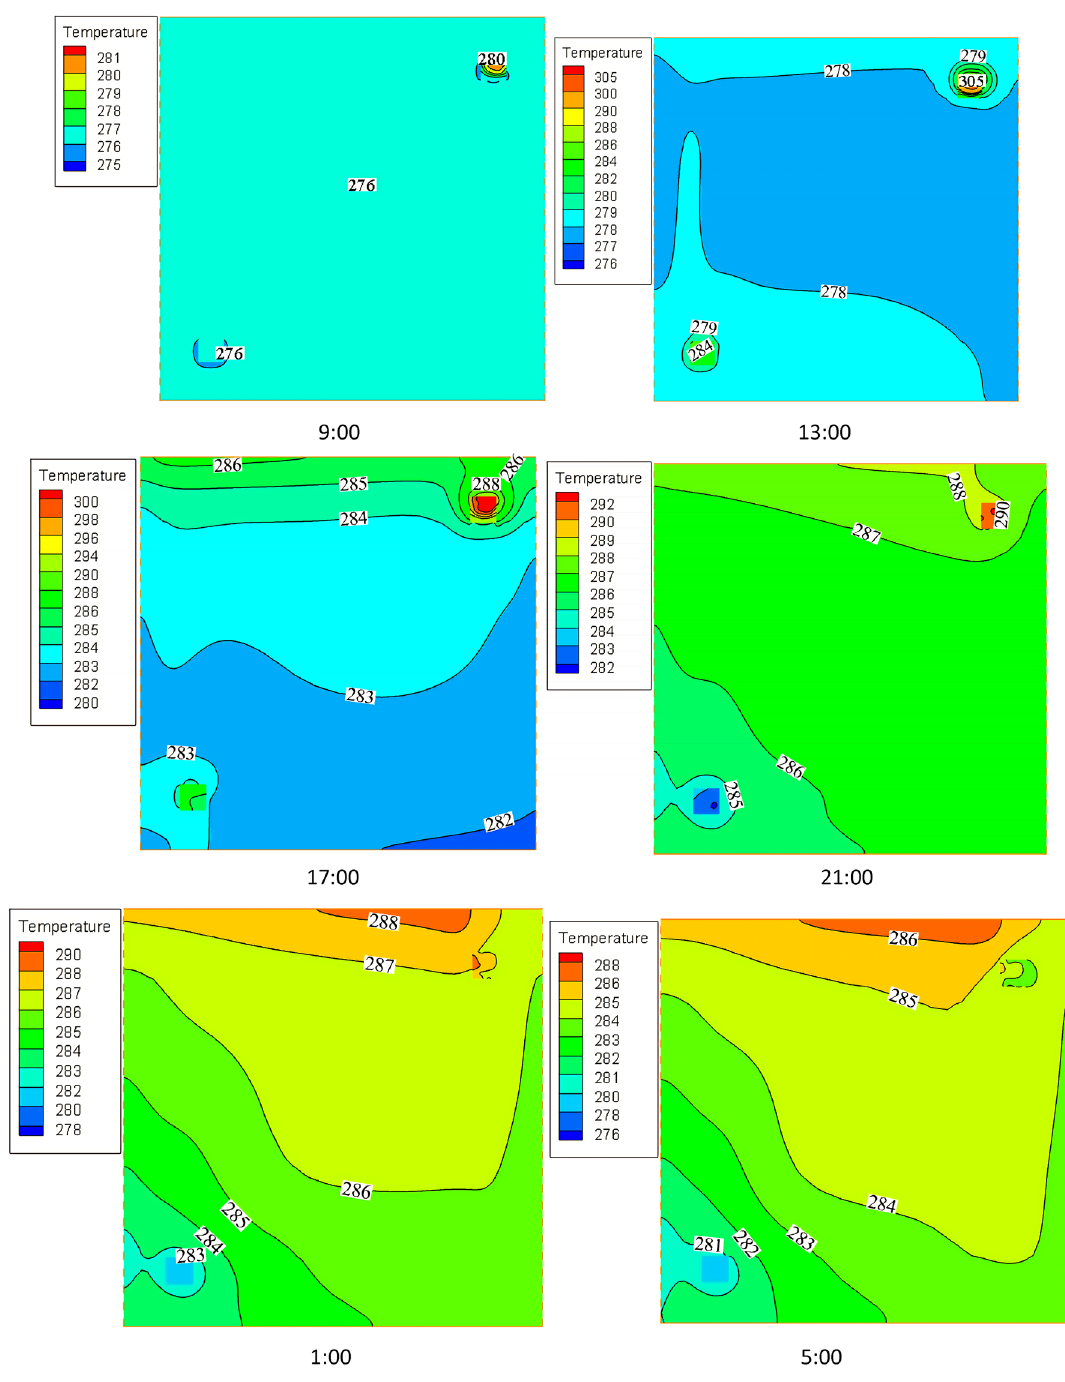
Figure 10. The internal temperature field of the thermal storage wall at different